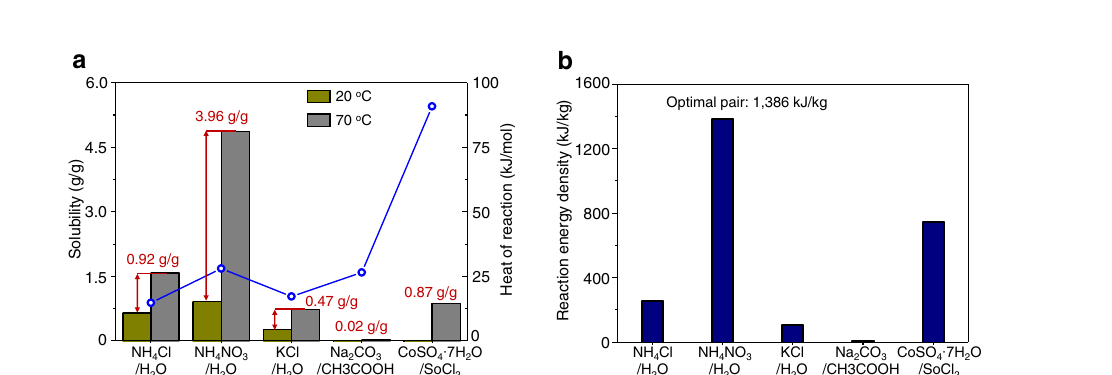
Fig. 2 | Latentcooling behaviorofporous materials.a Water sorptionperformance ofzeolite 13X. b Latent cooling energy density considering watersorptioncapacity and heat of reaction. Source data are provided as a Source data fi